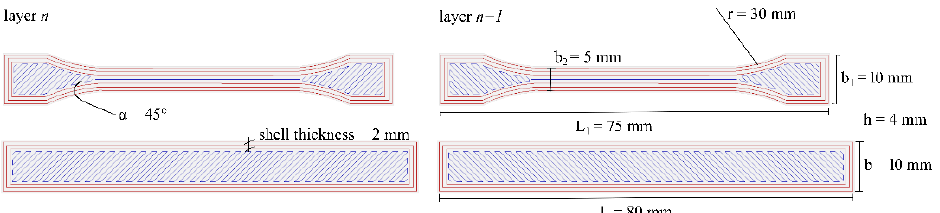
Figure 1. Dog-bone and prismatic test specimen dimensions and infill orientation pattern.